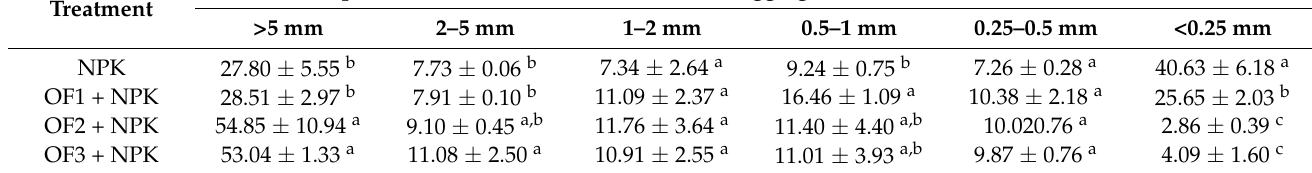
Table 2. Effects of organic–inorganic fertilizers on water-stable aggregate size fractions in a dry direct-seeded rice paddy